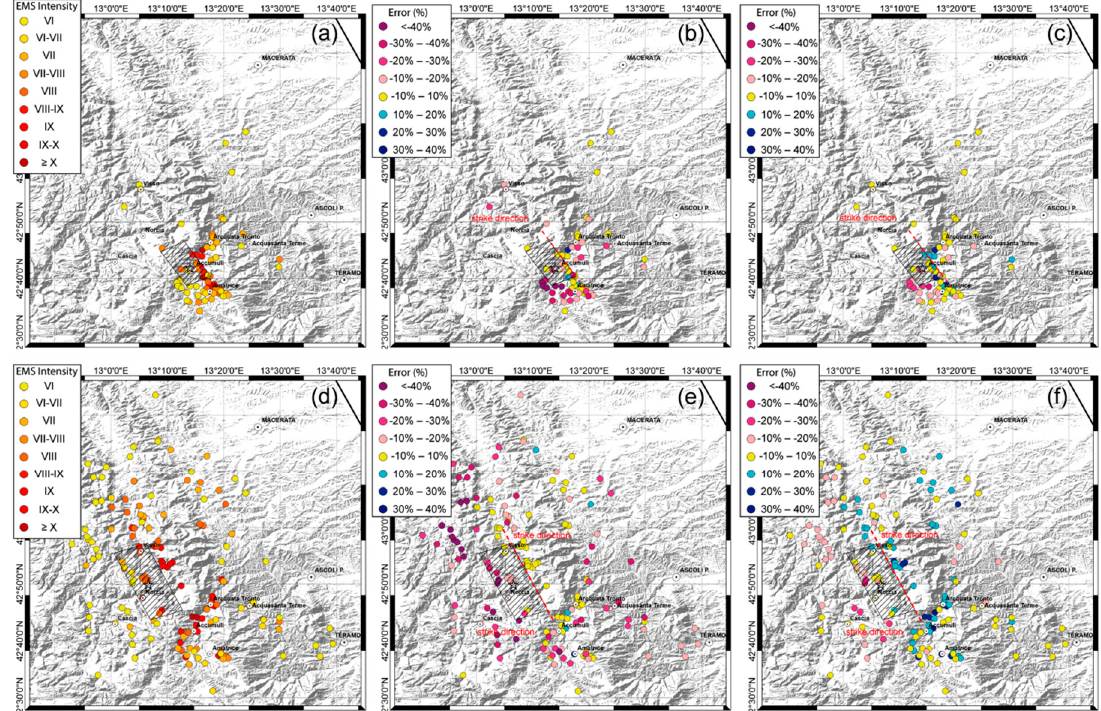
Figure 12. Comparison among predictions and observations: intensities obtained by macroseismic surveys ( a , d ) (http://www.questingv.it/); percentage errors between the observed intensities and those predicted according to the both models proposed by Tselentis and Danciu [29], T&D08 ( b , e ) and T&D08-2 ( c , f ). Negative values indicate predictions greater than observed intensities, and vice versa. The predicted intensities are obtained as the mean of those based on cumulative absolute velocity and Arias intensity. Intensities and comparisons obtained for the M W 6.0 Amatrice (upper layer) and M W 6.5 Norcia earthquakes (lower layer) are reported.